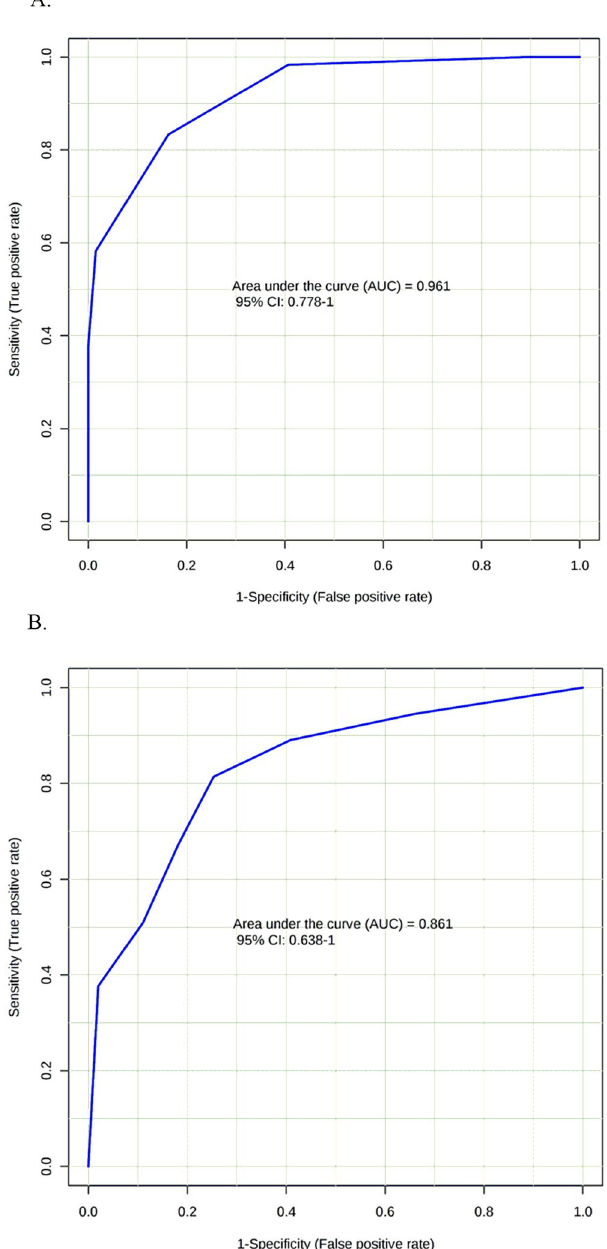
Figure 4. Receiver operating curves (ROC) of fatty acids for the differential identification of feed efficiency on steers. (A ) Rumen fluid ROC using the combination of pentadecanoic acid, palmitic acid, linoleic acid and alpha-linolenic acid. ( B ) Plasma ROC using the combination of arachidonic acid/docosahexanoic acid ratio and alpha-linolenic